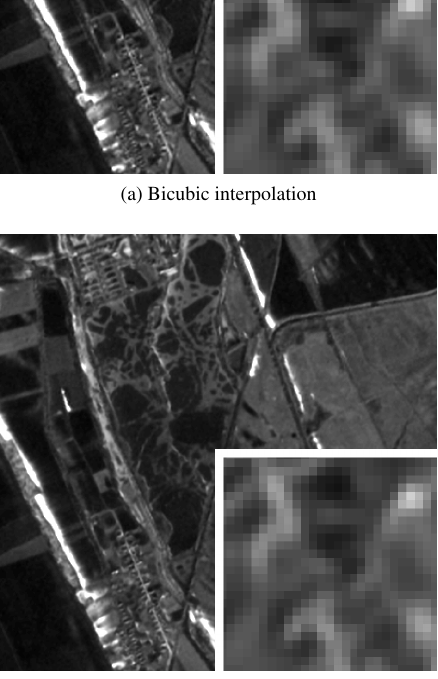
Figure 8: Actual up-scaling of a high-resolution input image